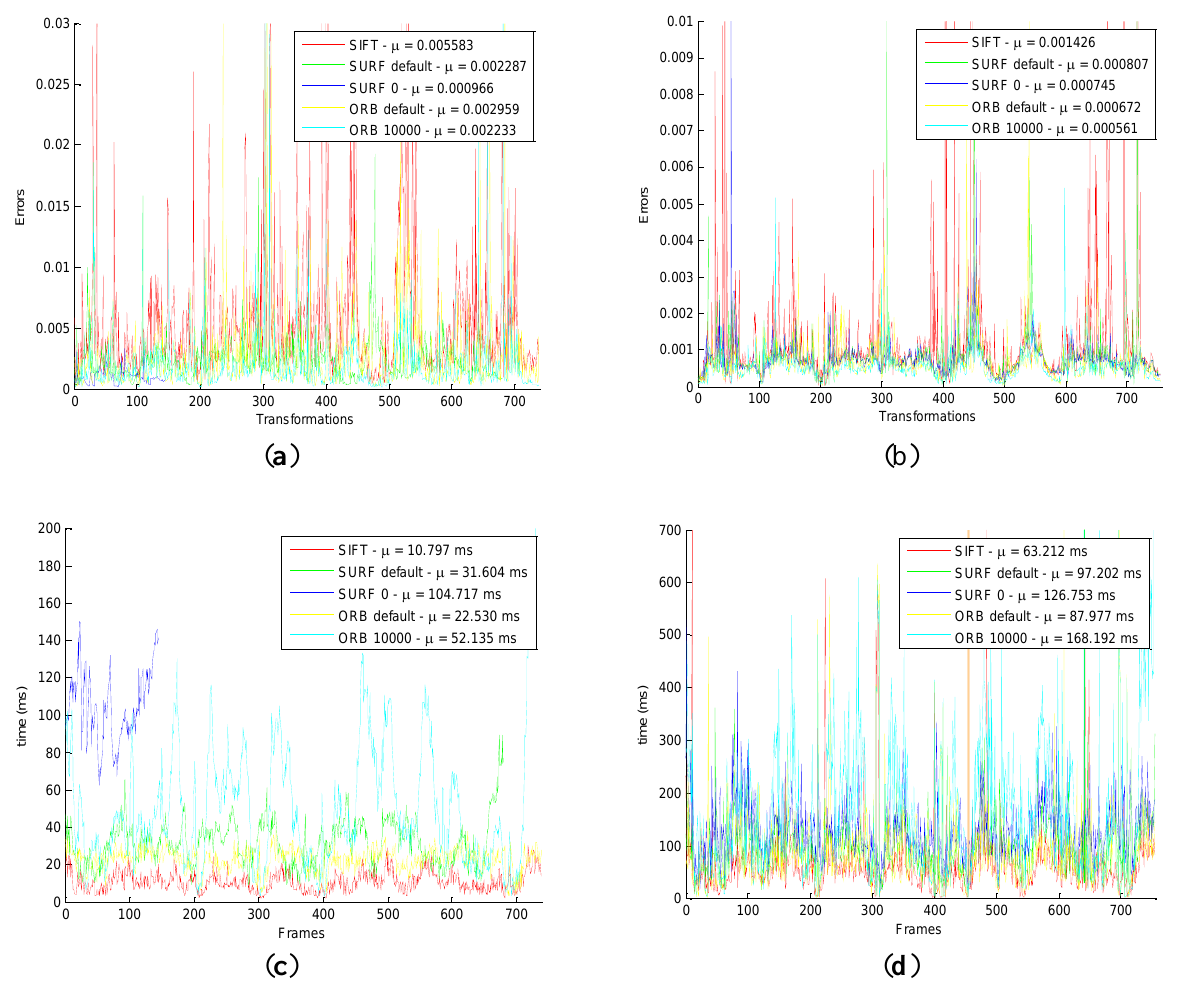
Figure 9. Comparison results of motion transformation optimization for all images in datasets. ( a ) The original error; ( b ) The improved error; ( c ) The original time consumption; ( d ) The improved time